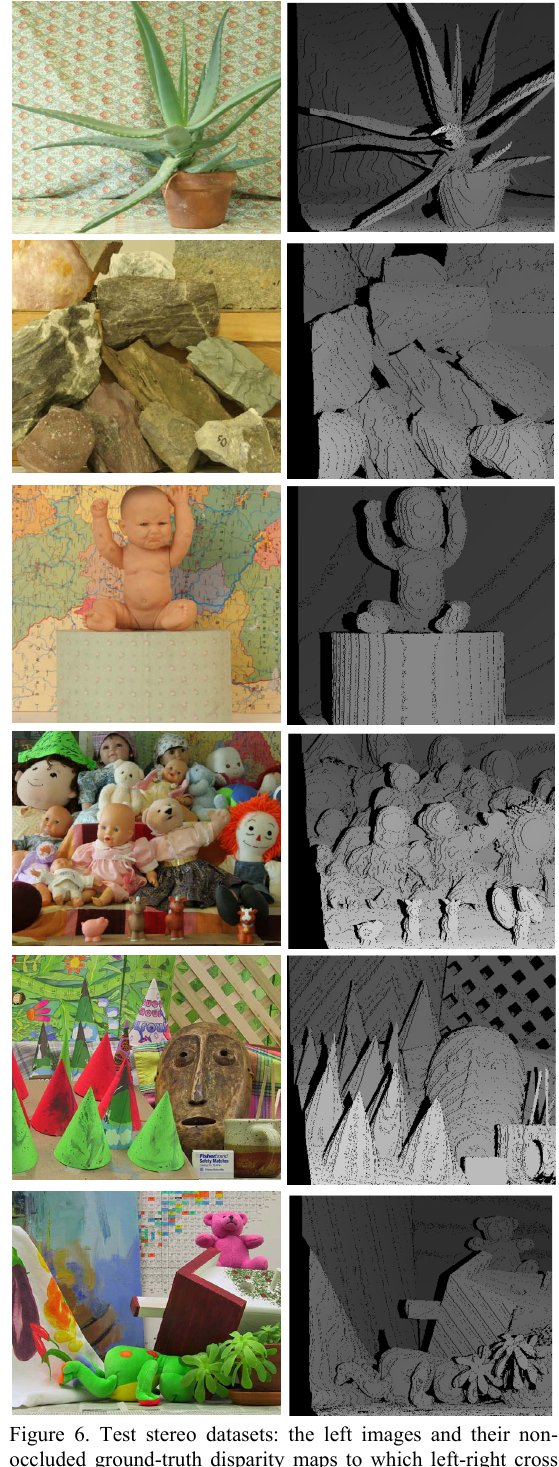
Figure 6. Test stereo datasets: the left images and their non- occluded ground-truth disparity maps to which left-right cross checking was applied.